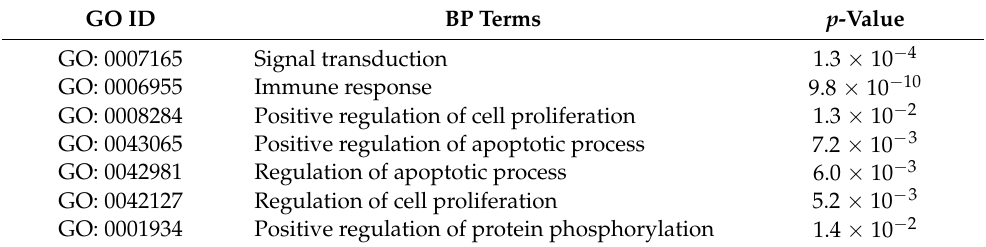
Table 3. Significant BP terms of 133 upregulated DEGs overlapped with IMPAGT.